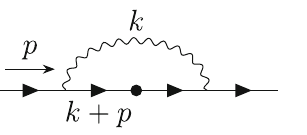
Fig. 2 One-loopself-energydiagram,withasingleinsertionof f (rep- resented by the dot) along the fermion propagator using Feynman parameters and l = k + xp , so that (cid:18)